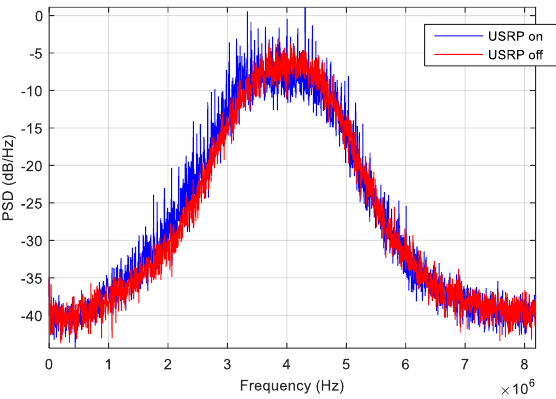
Sensors 2018 , 18 , x FOR PEER REVIEW Figure 16. PSD evaluation when the USRP is turned on/off. Figure 16. PSD evaluation when the USRP is turned on/off.